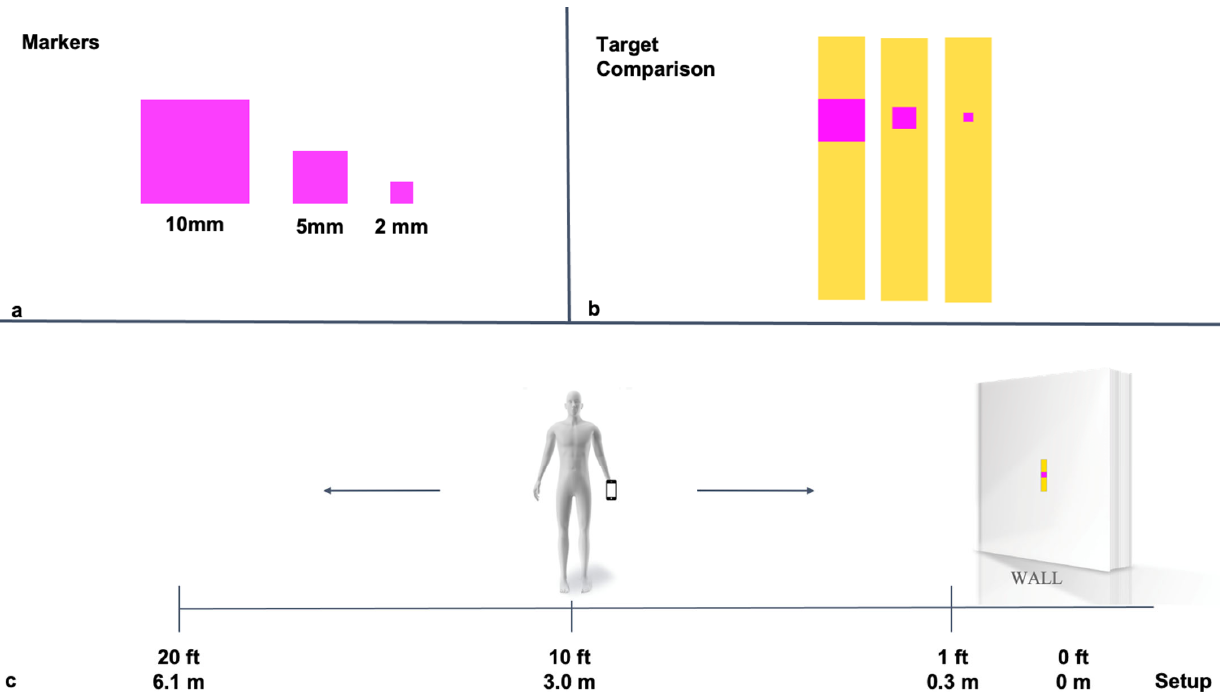
Figure 2. Protocol 1: Configuration for single target resolution. Neon green or neon pink squares of